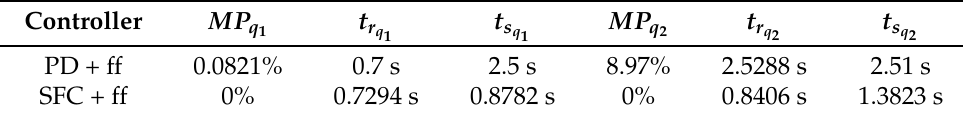
Table 7. Transient response comparative of the simulation results with F C